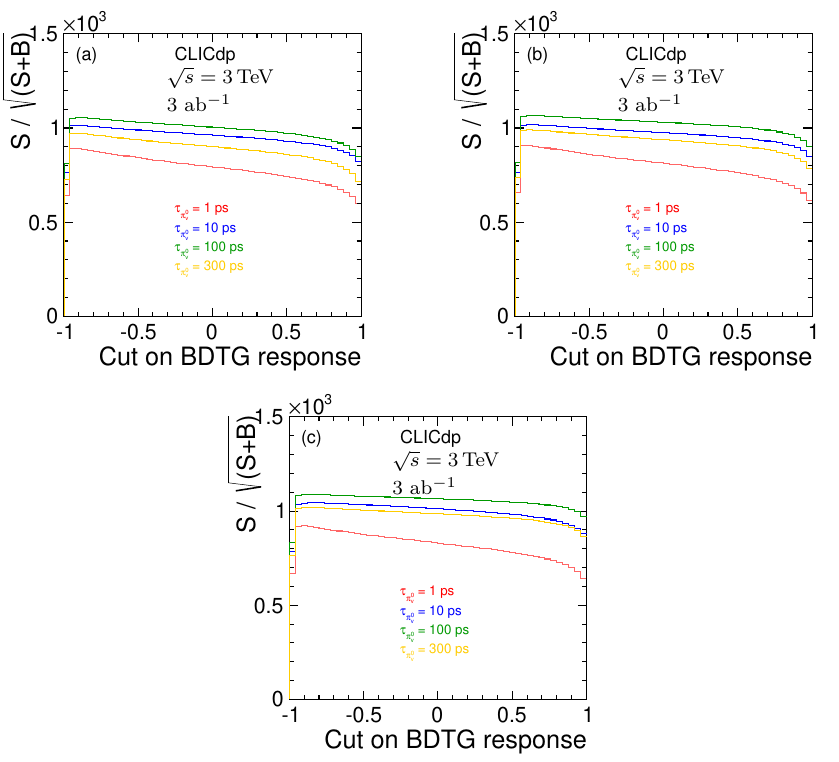
√ Figure 6 . Sensitivity S/ S + B for the expected number of events as a function of the cut on √ the BDTG response at s = 3 TeV, for signal samples of π 0 35 GeV/c 2 and (c) 50 GeV/c 2 , and for four different lifetimes: 1 ps (red line), 10 ps (blue line), 100 ps (green line) and 300 ps (yellow line). An integrated luminosity of 1 ab − 1 at √ and 3 ab − 1 at s = 3 TeV has been